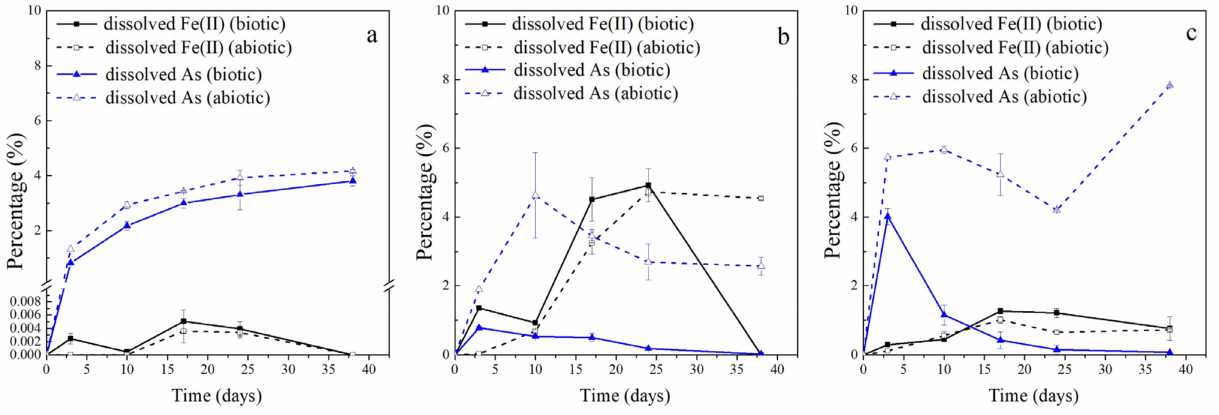
Figure 5. Variation in dissolved As and Fe(II) in the supernatant as percent extracted of total in soil under biotic and abiotic conditions with different LMWOAS amendments in remediated soils. ( a ) Oxalate, ( b ) citrate, ( c )